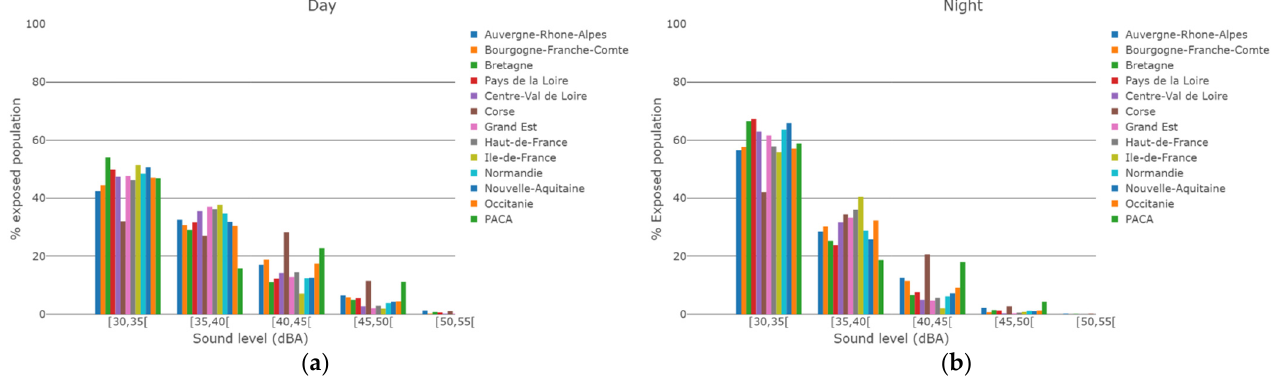
Figure 9. Number of people exposed to WT sound as a function of WT sound levels, normalized by the total number of people exposed to WT sound levels above 30 dBA: daytime ( a ) and night-time ( b ) meteorological conditions.